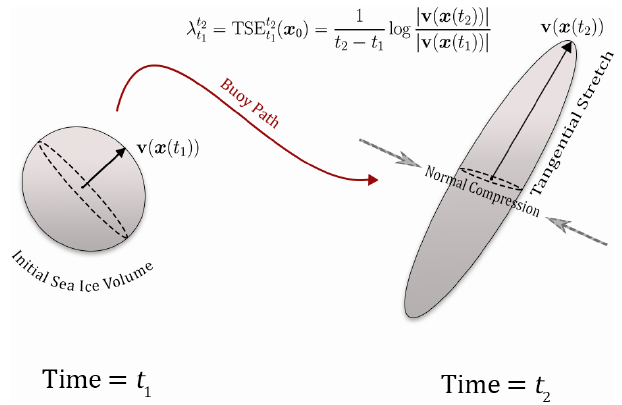
Figure 2. Example evolution of a small volume of sea ice surround- ing a buoy in a steady flow. From time t 1 to t 2 , the buoy velocity vector v (t) = v ( x (t)) increases, leading to compression in the plane of sea ice orthogonal to the buoy trajectory and positive